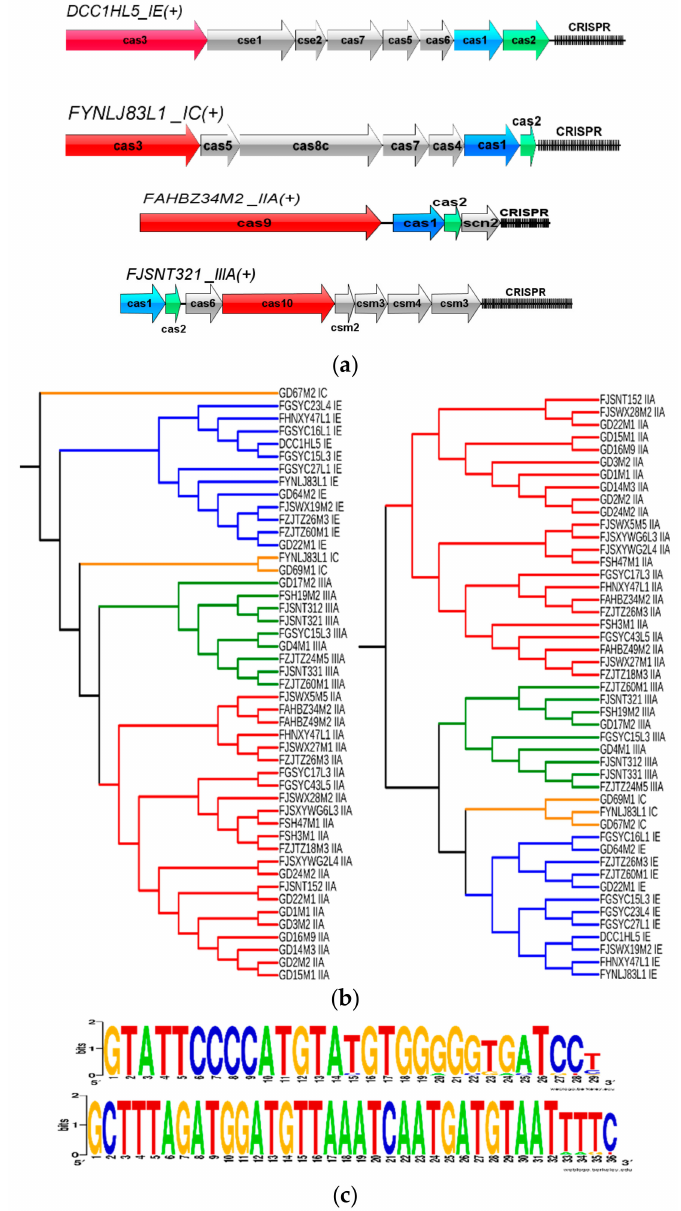
Figure 6. CRISPR-Cas systems in L. mucosae : ( a ) CRISPR loci in L. mucosae (four subtypes). The CRISPR locus was annotated and depicted with signature Cas genes colored in red, Cas3 for Type I, Cas9 for Type II, and Cas10 for Type III, and the universal Cas1 and Cas2 were colored in blue and green, respectively. Accessory genes were colored in a gray scale. CRISPR is represented using the fence graphics on the right side of each locus. ( b ) The phylogenetic tree constructed with Cas1 and DR sequences with four di ff erent subtypes in four colors. ( c ) Three kinds of Direct Repeats (DR) sequences in the same strain were visualized by using WebLogo. The height of the letter represented the frequency of the corresponding base at that